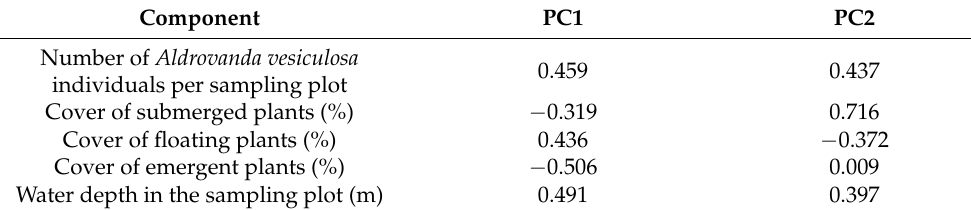
Table 5. Loadings of the analysed factors in first two principal